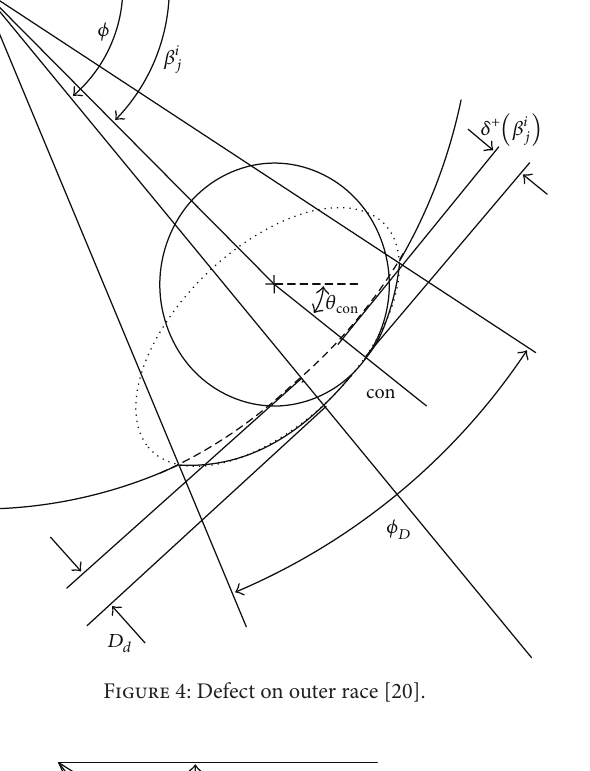
Figure 6: Properties of defect on outer ring.